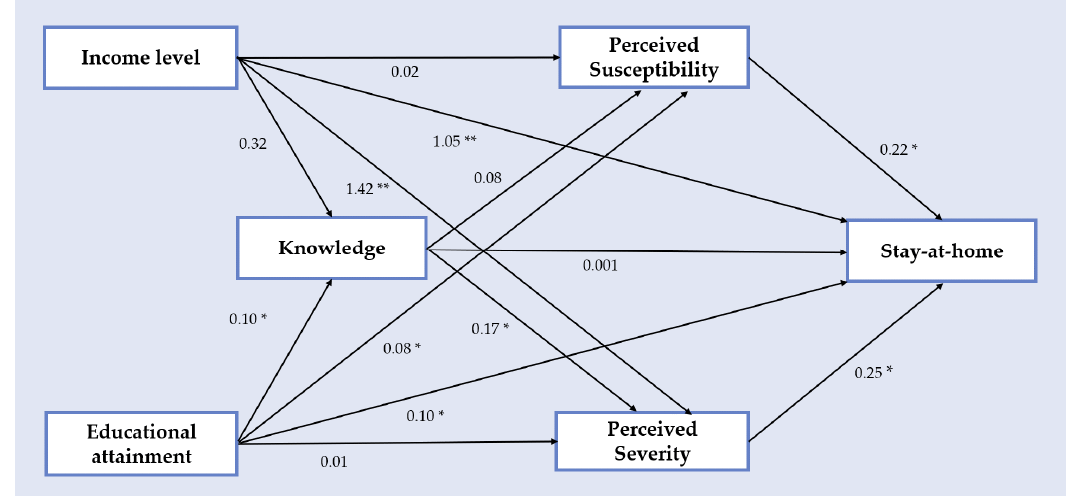
Figure 2. Path analysis model of stay ‐ at ‐ home behavior in adults ( ≥ 65 years old) in Mexico City related to income level, knowledge of coronavirus (COVID ‐ 19) symptoms, educational attainment, perceived severity of COVID ‐ 19. Coefficient of path analysis ( β ) * p < 0.05, ** p < 0.01. The model assumes that there is a correlation among variables at the same level.